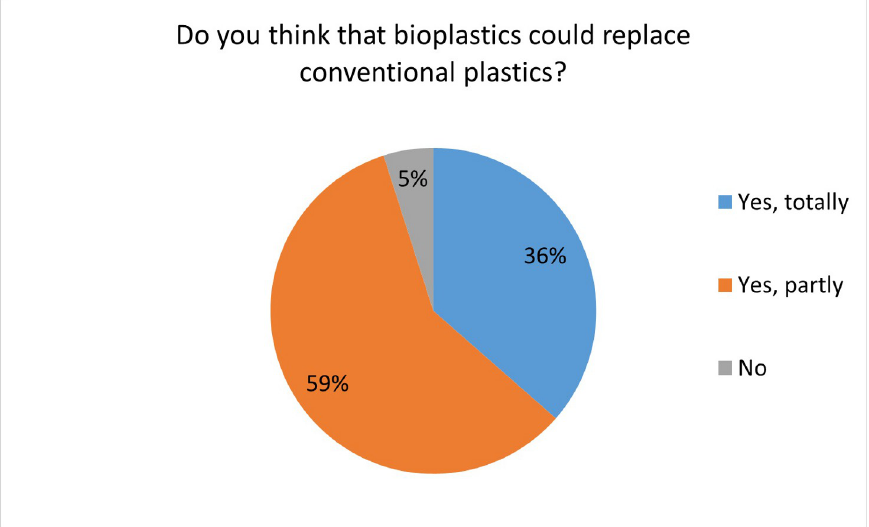
Fig 6. The possibility of bioplastics replacing conventional plastics (n =